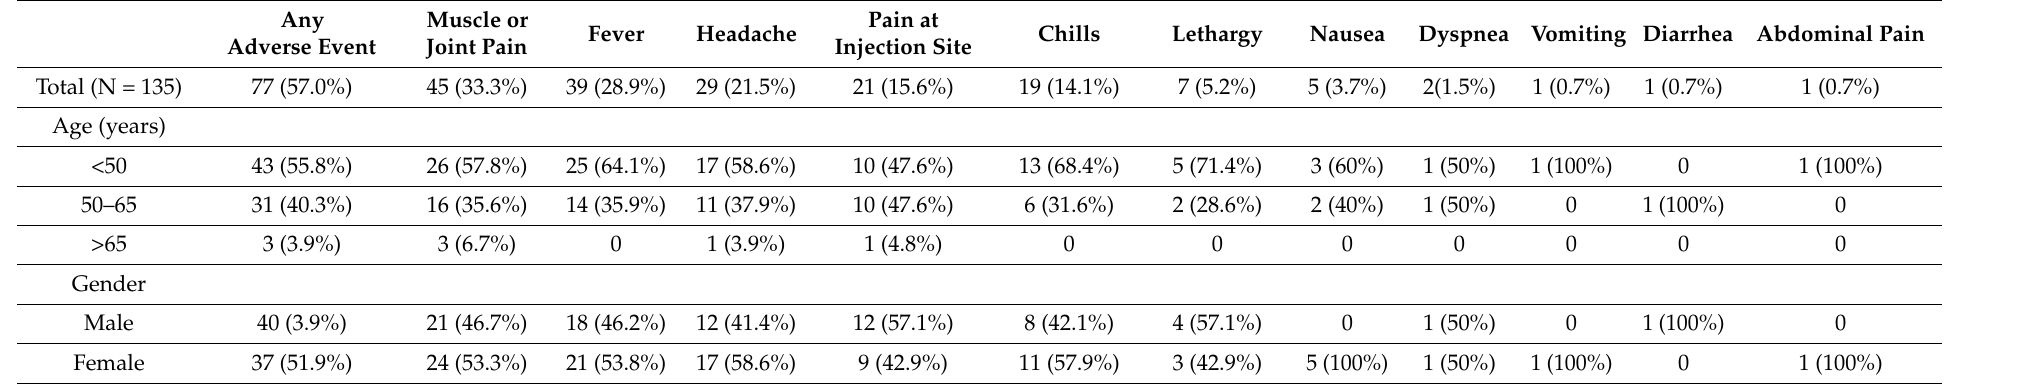
Table 4. Adverse events reported after BNT162b2 booster vaccination in the Gam-COVID-Vac primary vaccination cohort in subgroup analysis stratified by age and